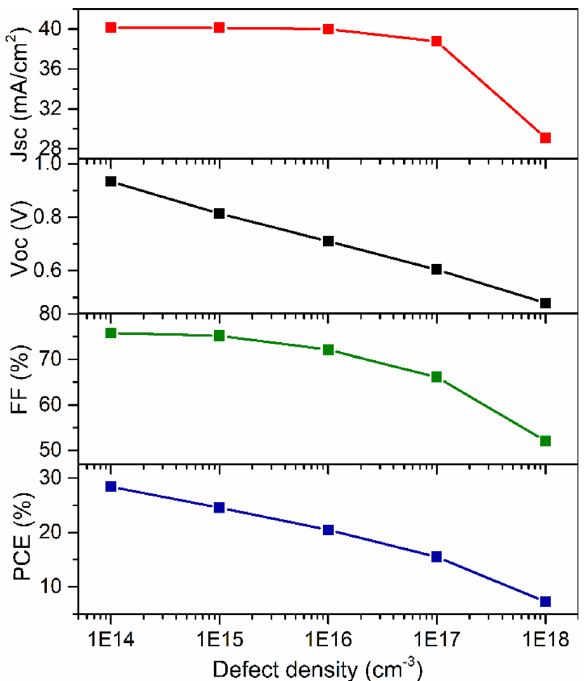
Figure 5. Photovoltaic response as a function of defect